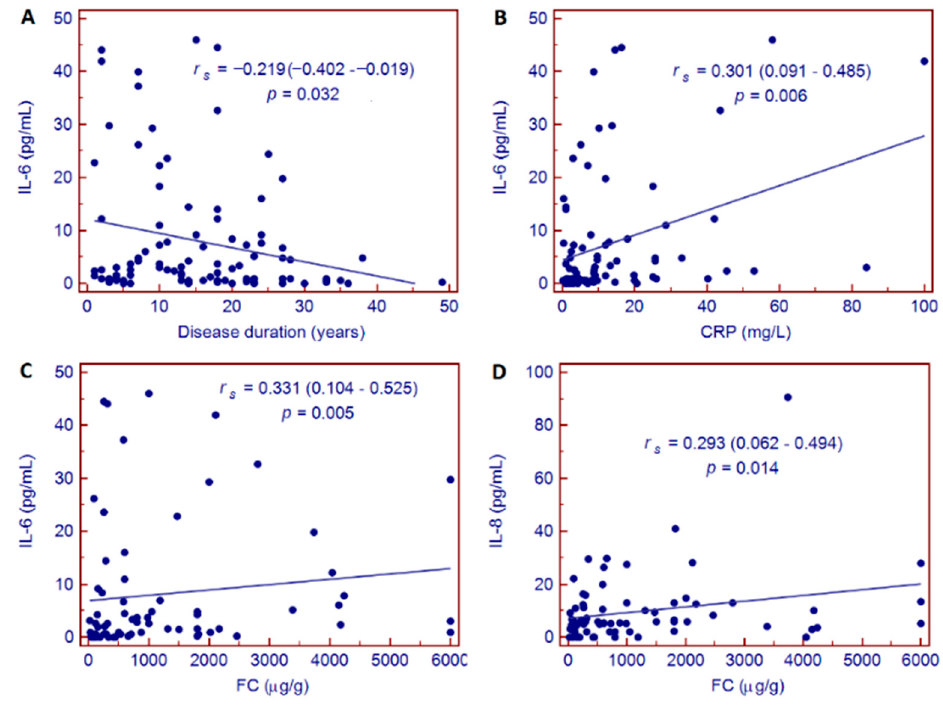
Figure 2. Correlation between IL-6 and disease duration ( A ), CRP values ( B ) and FC concentration ( C ); and between IL-8 and FC ( D ) in patients with IBD. Abbreviations: C reactive protein (CRP), fecal calprotectin (FC).